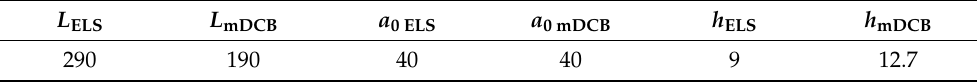
Table 4. Base geometrical parameters of the mDCB specimen. Dimensions in millimetres.